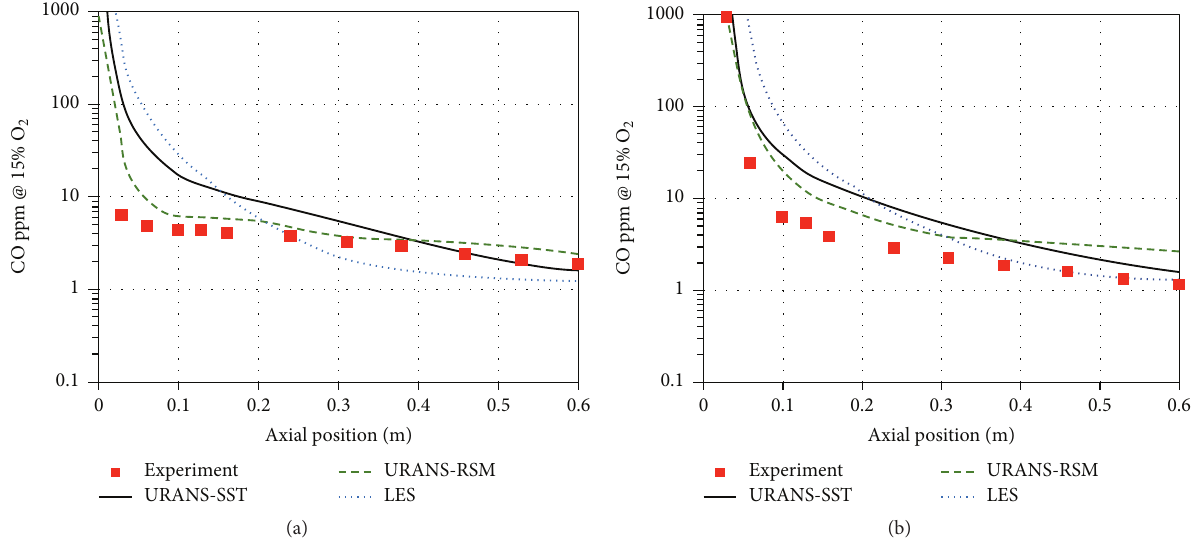
Figure11:Predictedandmeasuredprofilesoftime-averagedCOmassfractionalong(a)combustoraxisand(b)evaluationlineforNG-FGR20